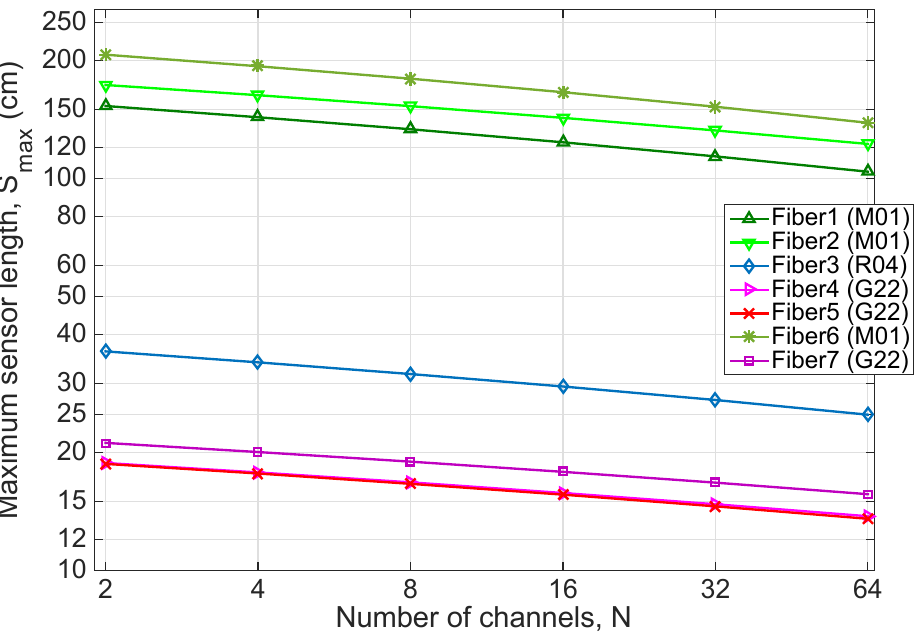
Figure 5. Maximum sensor length S max , as a function of number of channel N , in ideal conditions ( A = 0 dB, ∆ A = 0 dB), for the fibers listed in Table 2.